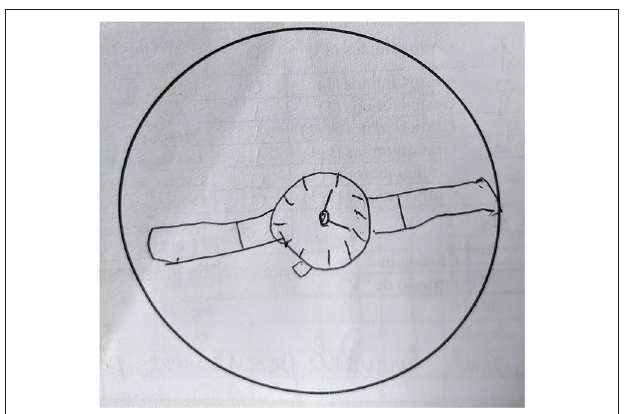
FIGURE 3 | Patient’s clock drawing test, showing visuospatial and executive functioning impairment.